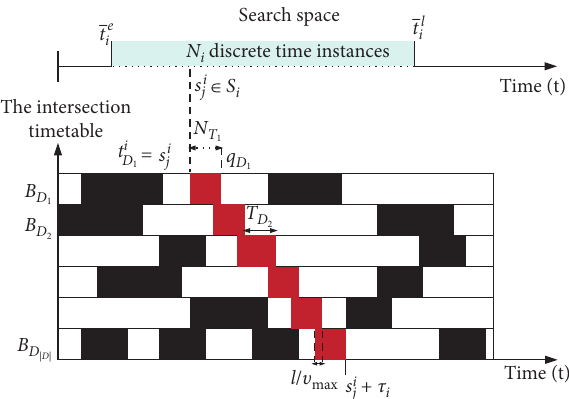
Figure 6: Graphical illustration of the intersection’s reservation timetable. The timetable is a buffer that stores for each cell of the IR its occupancy information with respect to time. For an arbitrary vehicle A i , the preliminary feasibility search identifies the elements of the set S i that correspond to an unreserved trajectory at the IR using the